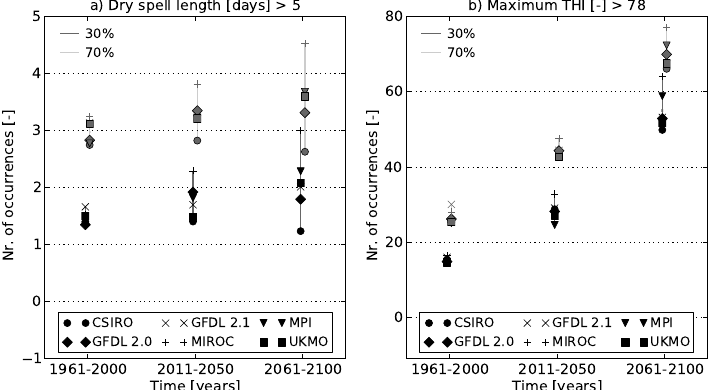
Fig. 3. Limpopo Basin-averaged changes in climatology from 1961–2000 to 2011–2050 to 2061–2100, of DJF frequency of occurrence of dry spells longer than 5days according to the 6 RCM projections. The dark symbols denote the 30th percentile. The grey symbols denote the 70th percentile. The dark lines indicate the multi-model range for the 30th percentile. The grey lines indicate the multi-model range for the 70th percentile.